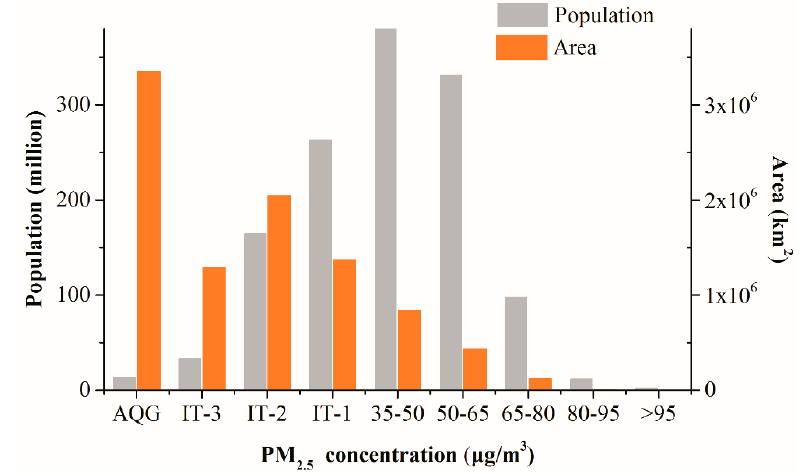
Figure 3. Area and population for each PM 2.5 concentration level. Abbreviations for the PM 2.5 standard levels used are as follows: AQG: Air Quality Guide Line; IT-1: Interim Target 1; IT-2: Interim Target 2; IT-3: Interim Target